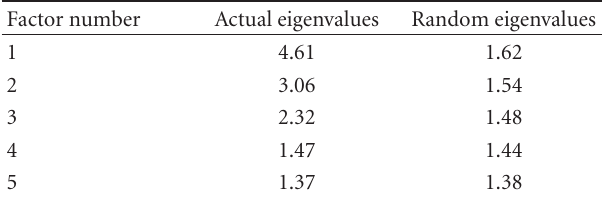
Table 2: Comparison of eigenvalues from the actual factor analysis and random eigenvalues from parallel